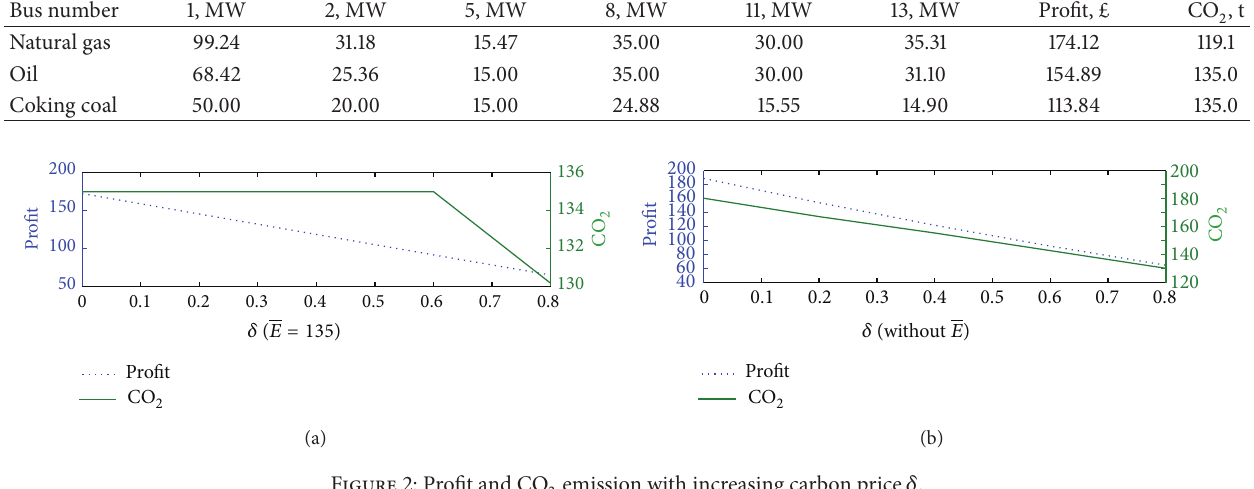
Figure 2: Profit and CO 2 emission with increasing carbon price 𝛿 .